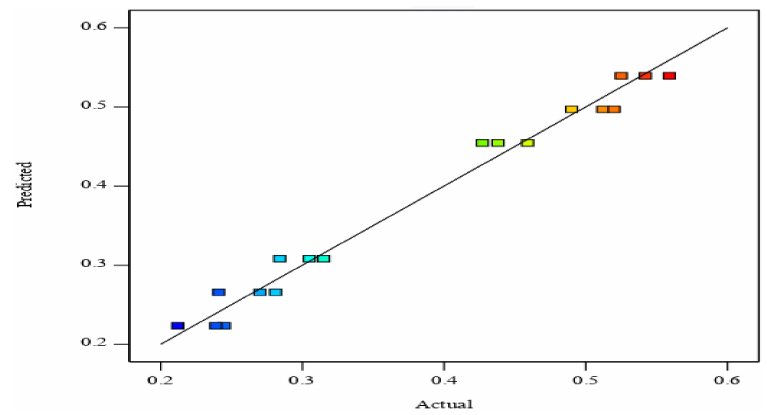
Figure 14. Plot of the actual versus predicted values of the linear